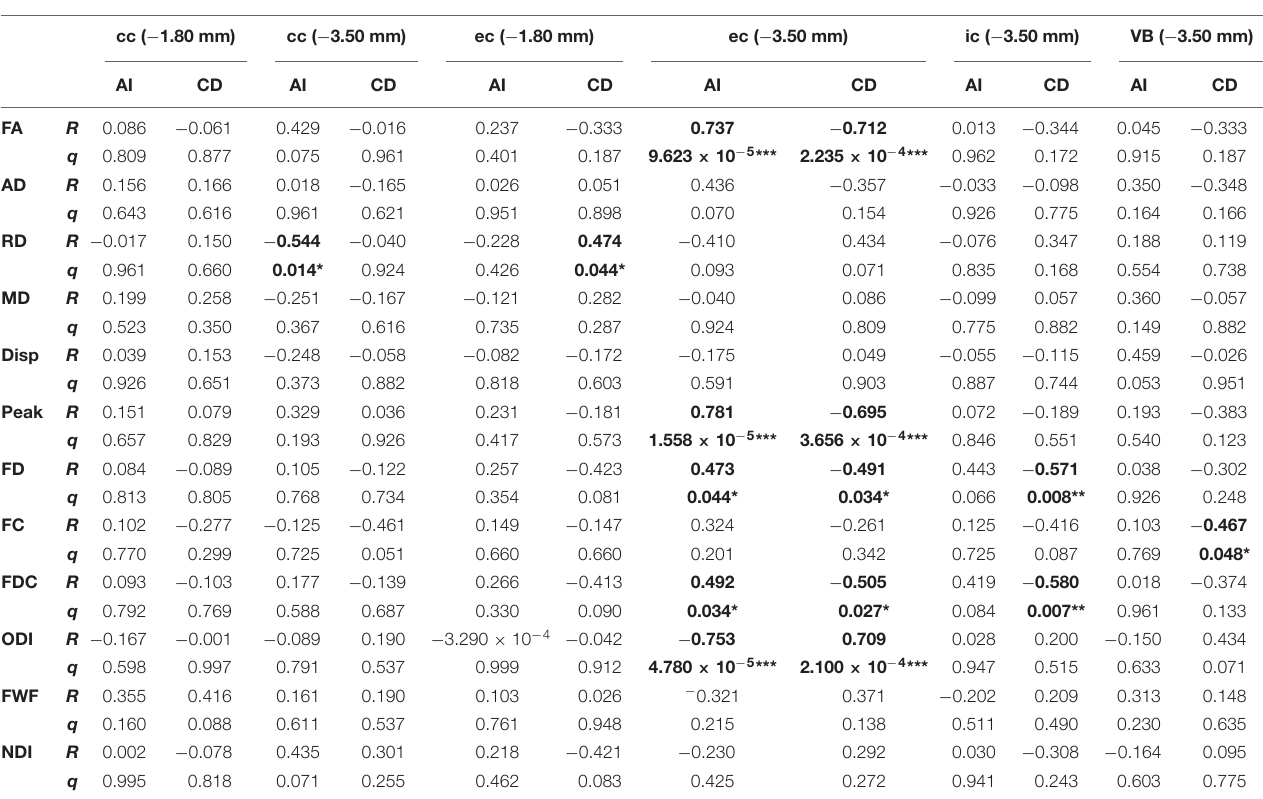
TABLE 1 | Coefficient (R) and q -values (q) from the Pearson’s correlations between dMRI and histological metrics. cc ( − 1.80